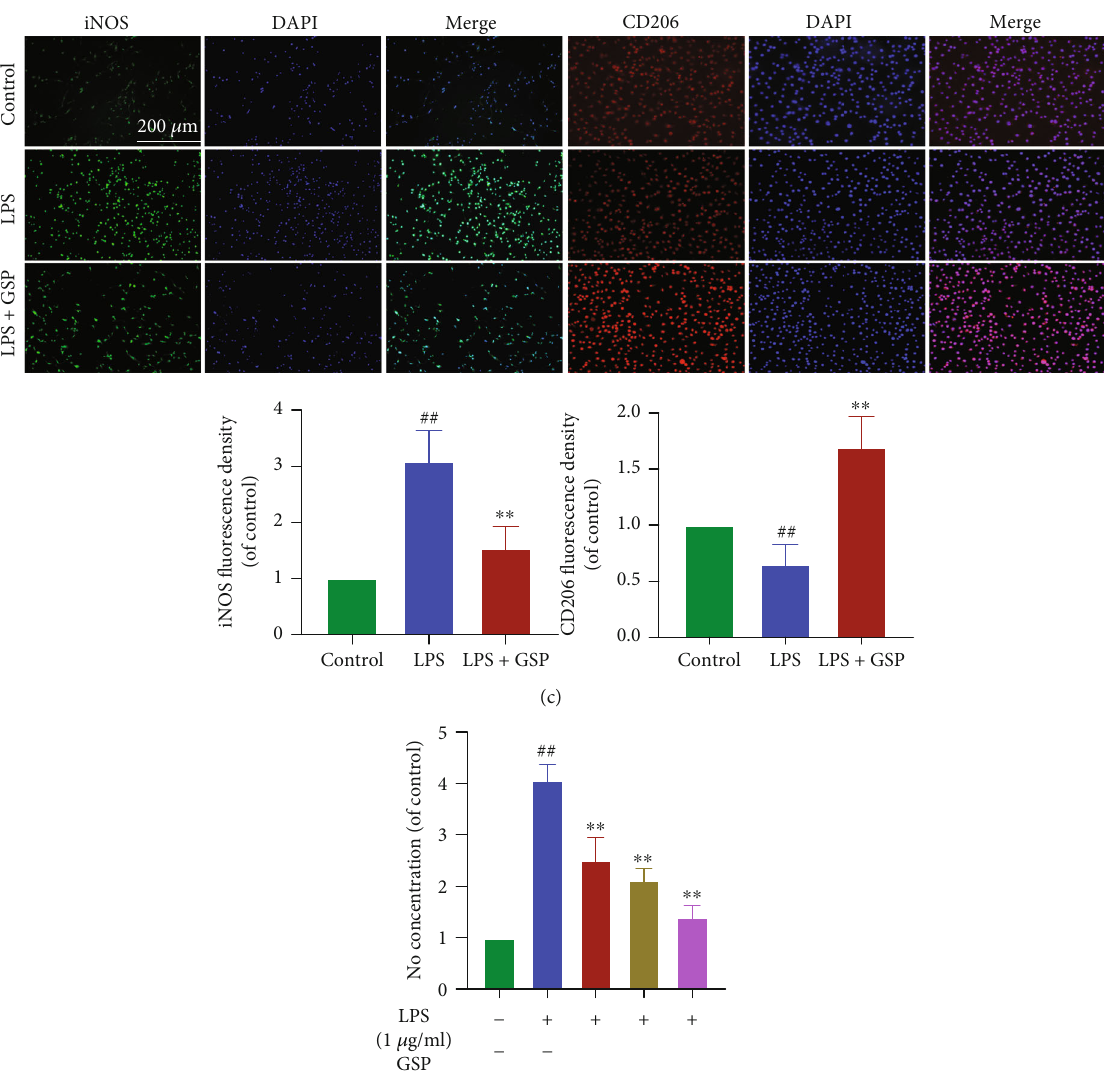
Figure 7: E ff ect of GSP on microglial polarisation in vitro . (a) Morphological results and IF for Iba1 in each group. Scale bar = 200 μ m . (b) Representative WB and quantitative data of M1/M2-related proteins. (c) IF and quantitative data of iNOS and CD206 in each group. (d) NO concentration of each group. ## p < 0 : 01 vs. control group. ∗∗ p < 0 : 01 vs. LPS-treated